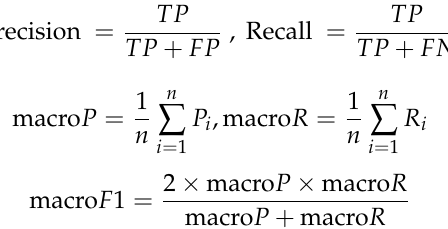
Figure 8. Body gesture recognition model accuracy ( a ) and loss ( b ) over the epochs. After training for 100 epochs, the model achieves 99.79% precision on training data and 99.80% accuracy on testing data. In Figure 9, the diagram on the left presents the confusion matrix with predicted labels on X -axis and true labels on the Y -axis for predictions utilizing our model tested on the training dataset. The diagram on the right presents the confusion matrix with predicted labels on X -axis and true labels on the Y -axis for predictions utilizing our model on the testing dataset. The high density at the diagonal shows that most of the body rescue gestures were predicted correctly. The performance is well over and close to perfect in most of the gestures. In the confusion matrix, we can see that the amount of data for Attention and Cancel is relatively large. This is because, in the data collection part, we collect the largest amount of data for Attention and Cancel. These two gestures are dynamic body gestures and well separated from the static gesture patterns, which represent the set and reset functions respectively. In Figure 10, the diagram on the left presents the standard matrix with predicted labels on X -axis and true labels on the Y -axis for predictions utilizing our model tested on the training dataset. The diagram on the right presents the standard matrix with predicted labels on X -axis and true labels on the Y -axis for predictions utilizing our model on the testing dataset. The standard matrix is a scale for correctly identified gestures and mistakes, it shows that all body gestures in the training set have reached 1.00, and in the test set, all body gestures except Punch 0.98, Attention 0.99, and Walk 0.99 also reach 1.00. The sum of each row in a balance and normalized confusion matrix is 1.00, because each row sum represents 100% of the elements in a particular gesture. In addition to using the confusion matrix as an evaluation metric, we also analyzed the performance of the model from other standard metric. we use the equations below to calculate the macro-average. Based on the true positive (TP), false positive(FP), false negative(FN), and true negative(TN) of the samples, we calculate the p value (Precision), and R value (Recall), respectively, and the result macro F1 value is mostly close to 1.00.